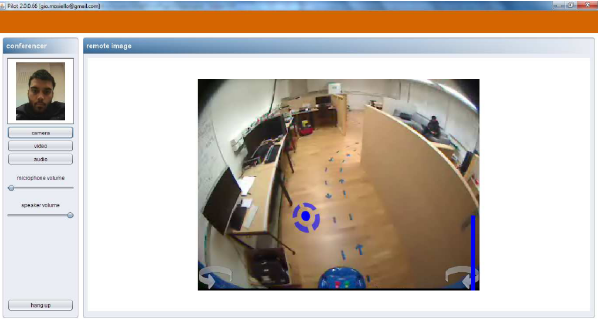
Figure 3. Giraff Pilot 2.0a